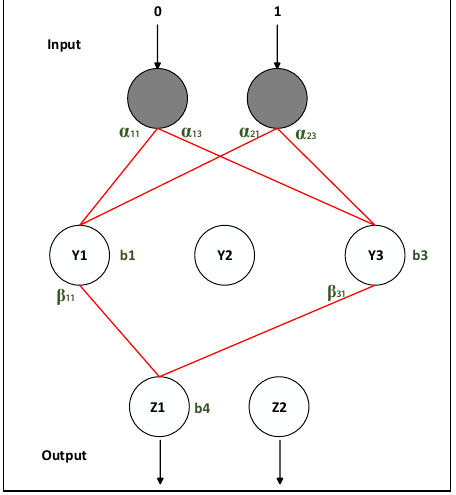
Figure 6. feeding the second coordinate vector (0,1) to get the second component of the etalon (𝑊 𝑋 ) 𝑍 . Components that were 1 frizzed during step 1 of the algorithm 1 aren’t